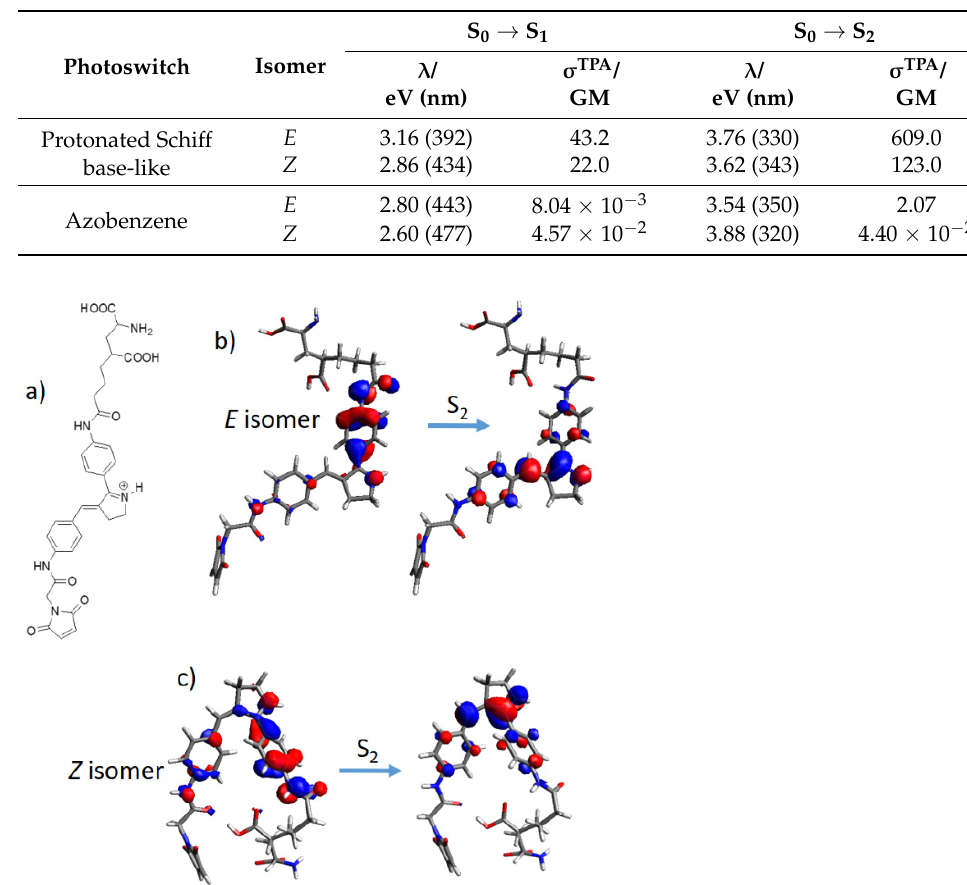
Table 2. Vertical transition energies, calculated as energy difference between the electronic ground state and the selected excited state ( λ ), and TPA cross section values ( σ TPA ) for two photoswitches (azobenzene, A, and protonated Schiff base-like, PSB) included as the core of the M-A-G and M-PSB-G structures. Level of theory: CAM-B3LYP/6-31+G*.